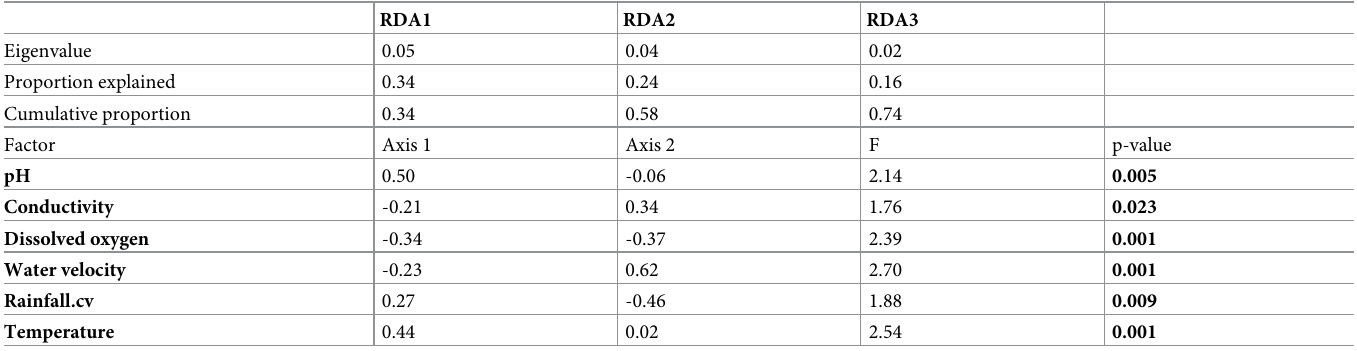
Table 8. Eigenvalues and proportion explained by the first three axes of RDA along with axis loadings of environmental variables on first two RDA axes along with their significance based on permutation tests (number of permutations = 999) in MP. Values lesser than 0.05 (in bold) are considered as significant explanatory factors for the community